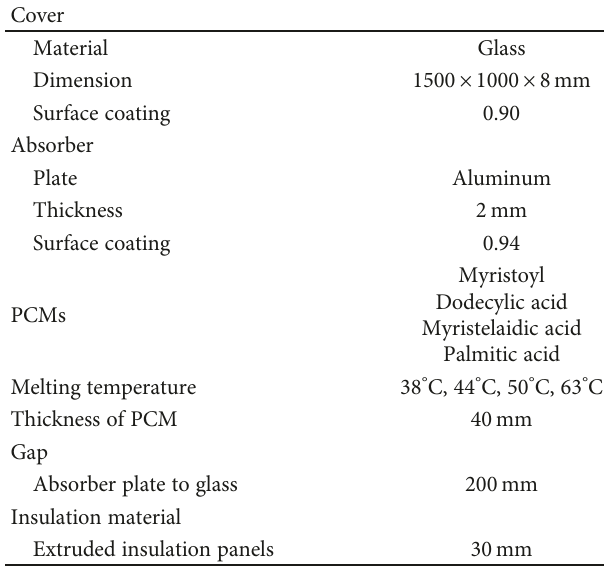
Table 1: Speci fi cations of the solar chimney and the thermo- physical properties of